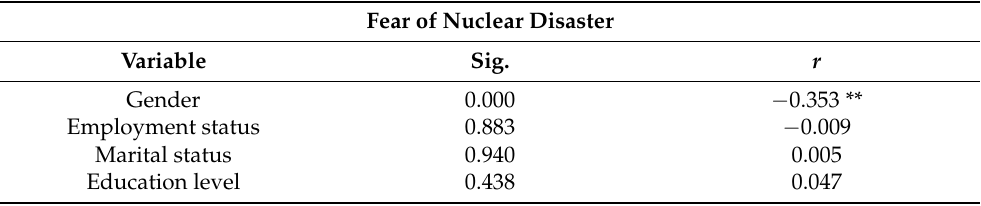
Table 6. Pearson’s correlation between fear of nuclear disaster and variables. Fear of Nuclear Disaster Variable Sig. r Gender 0.000 − 0.353 ** Employment status 0.883 − 0.009 0.940 0.005